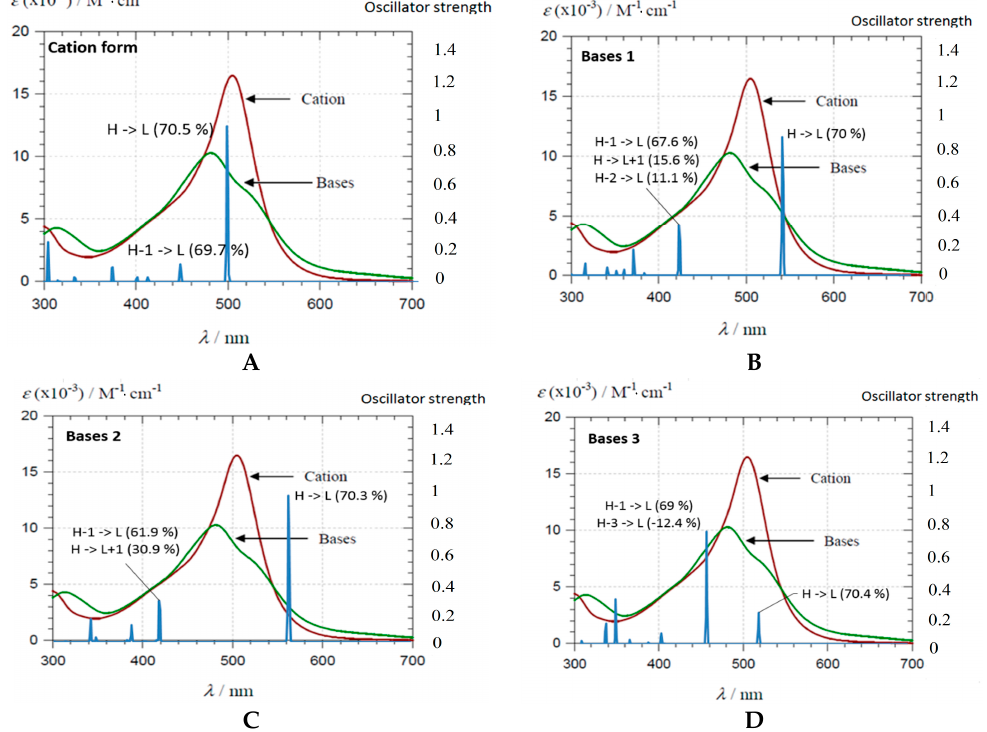
Figure 3. Experimental and theoretical (TD-DFT) UV-visible absorption spectra of PA1 for: ( A ) AH + ; and the three A forms resulting from deprotonation of: C4E-OH ( B , base 1); C4B-OH ( C , base 2); and C7A-OH ( D , base 3).